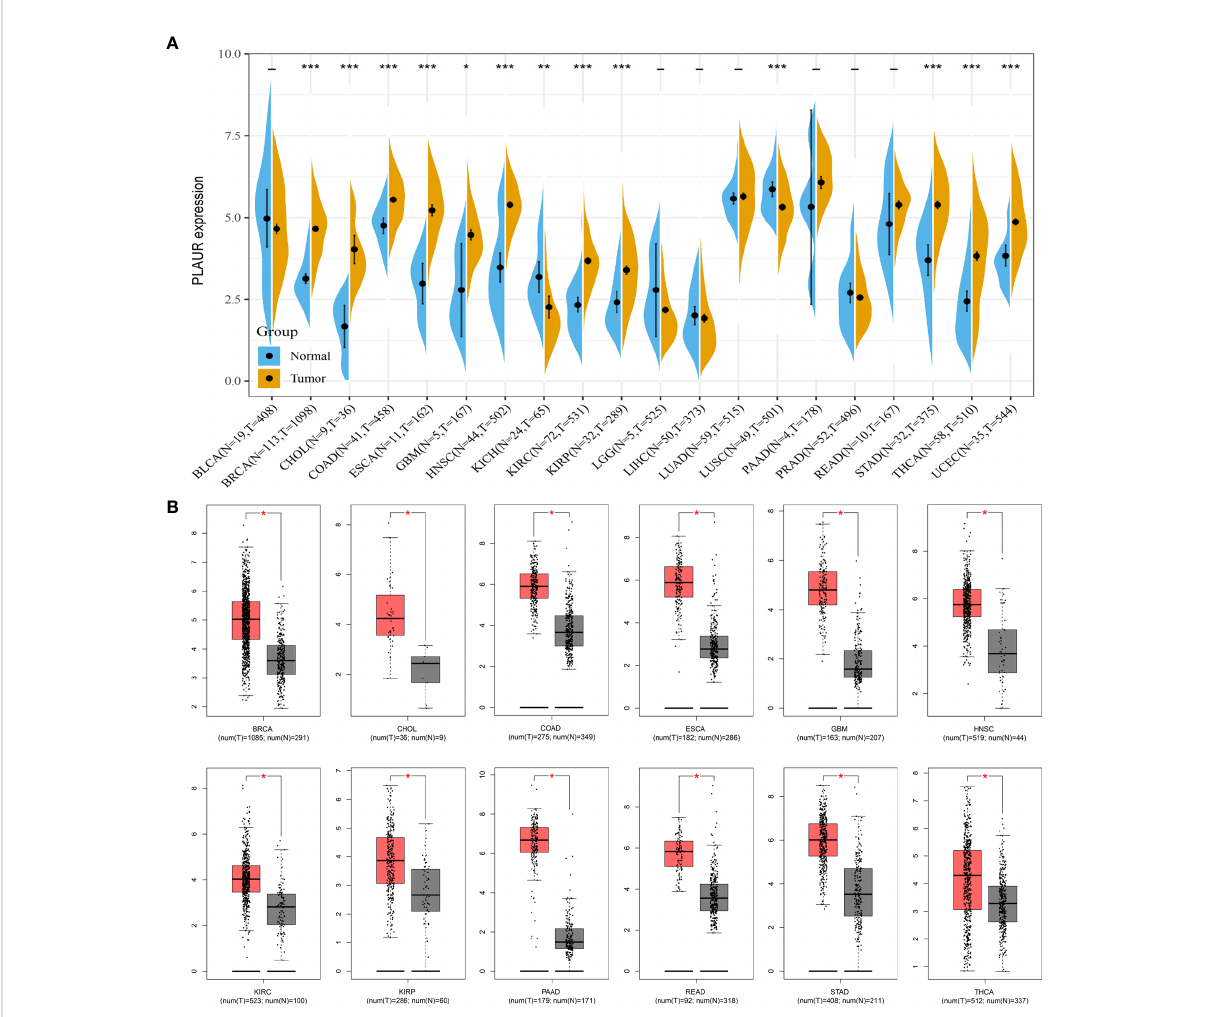
FIGURE 1 Expression analysis of PLAUR in pan-cancer. (A) The expression of PLAUR in 20 neoplastic tissues based on TCGA database. (B) The expression of PLAUR was higher in 12 cancer tissues compared with corresponding TCGA and GTEx normal tissues. * P value< 0.05; ** P value< 0.01; *** P value <